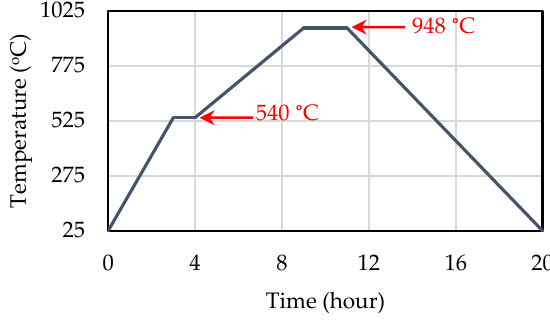
Figure 1. Temperature–time program used to sinter the PZT plates.